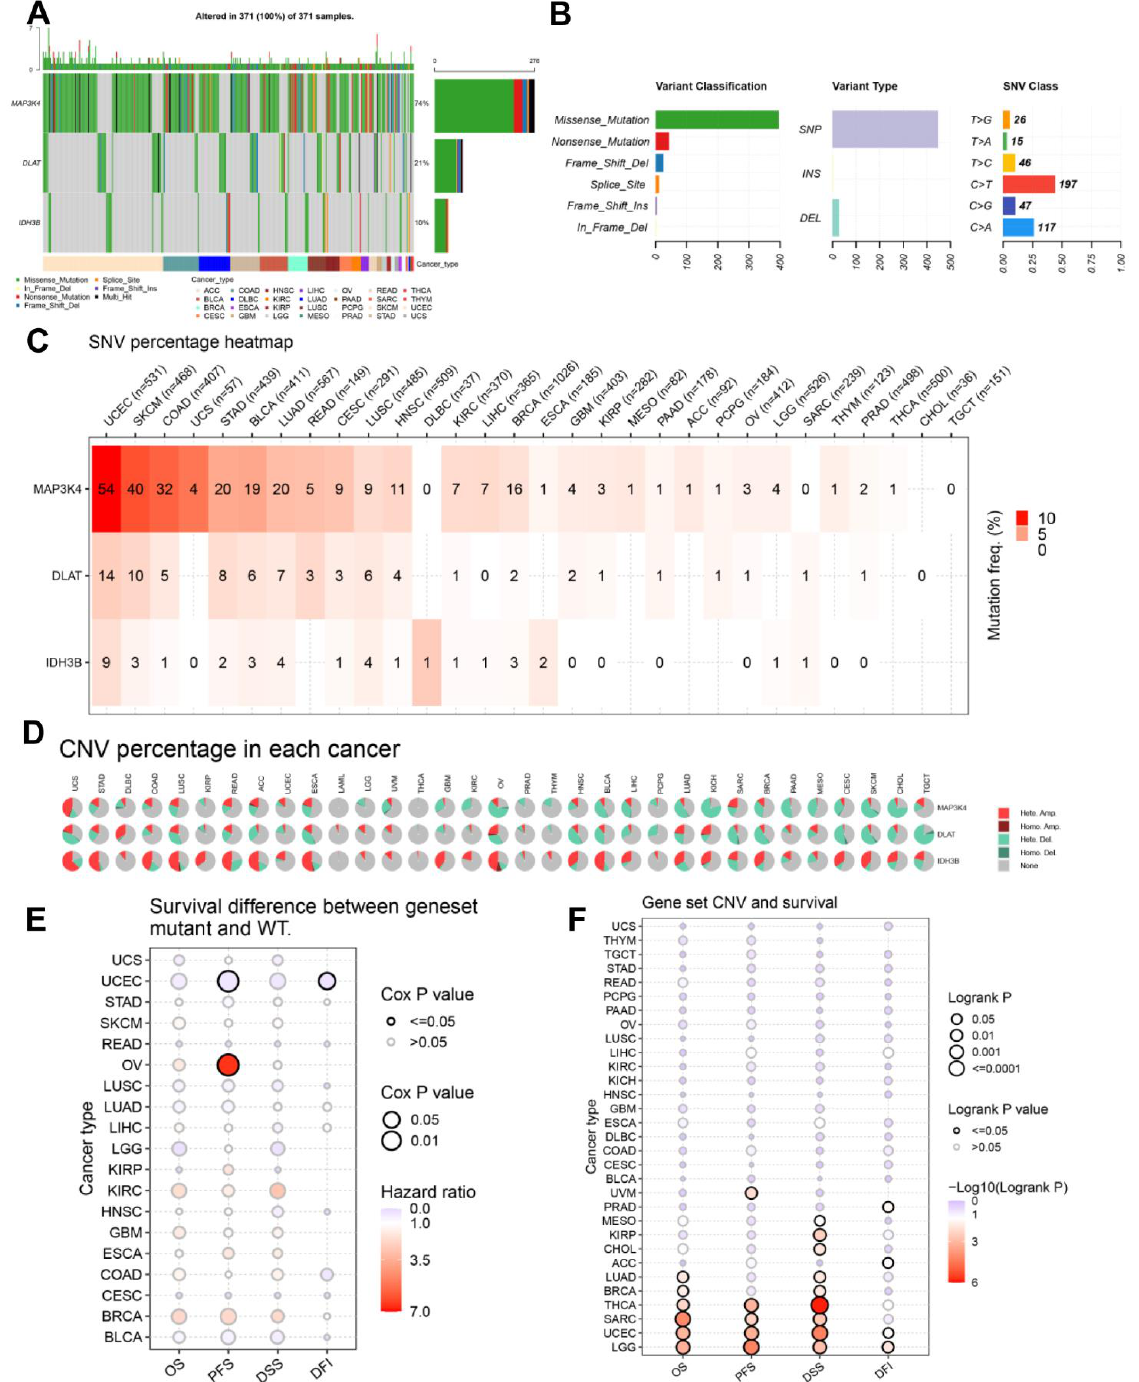
Figure 10. The landscapes of mutation based on GSCA. ( A ) SNV information (deleterious) of MAP3K4, DLAT, and IDH3B in each sample was shown in the waterfall plot. Different mutation types were identified by color. ( B ) According to classification categories, missense mutation, SNP, and C > T mutation accounted for a larger proportion. ( C ) The SNV percentage heatmap of MAP3K4, DLAT, and IDH3B in pan-cancer. ( D ) The CNV percentage pie plots of MAP3K4, DLAT, and IDH3B in pan-cancer. ( E ) The survival difference between gene set mutant (deleterious) and wide type in pan-cancer. ( F ) The survival difference between gene set CNV and wide type in pan-cancer. SNP, single-nucleotide polymorphism; SNV, single-nucleotide variant; CNV, copy number variation; OS, overall survival; PFS, progression-free survival; DSS, disease specific survival; DFI, disease free in- terval. 3.9. Drugs Sensitivity and Response Analysis The correlations between the gene set expression and drug sensitivity (top 30) in pan- cancer were summarized in Figure 11A and Table S6. We found that the expression level of the gene set was generally negatively correlated with drug sensitivity. Next, we evalu- ated the response of the gene set to therapeutic drugs in six real-world trial cohorts (Table